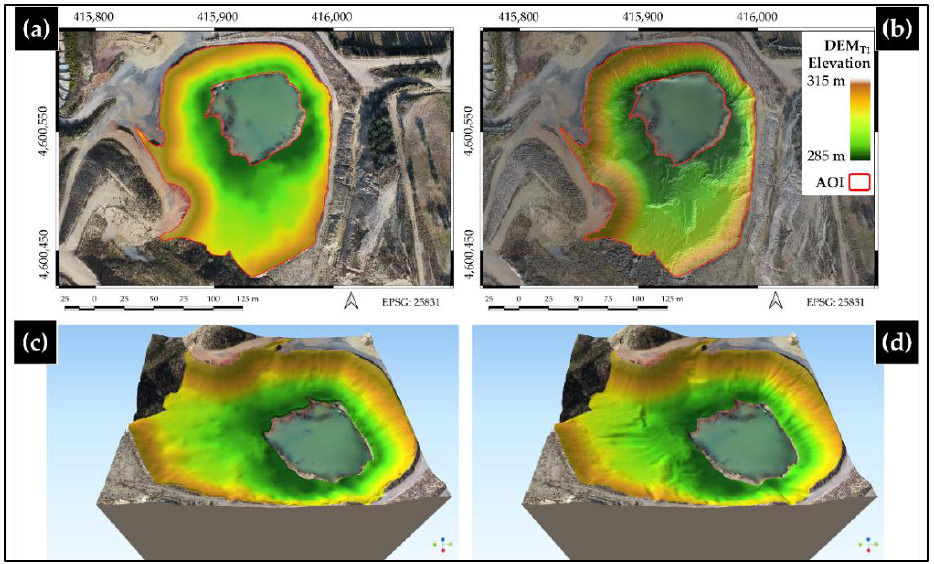
Figure 6. ( a ) DEM T0 of the Area of Interest (AOI), estimating the terrain morphology before the erosion process. ( b ) DEM T1 of the AOI based on drone-acquired imagery. ( c ) 3D representation of DEM T0 . ( d ) 3D representation of DEM T1 .